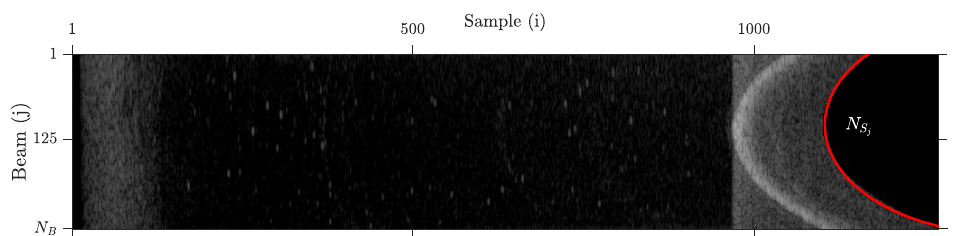
Figure 2. Raw representation as a 1270 × 256-pixel picture of water column amplitude samples from a ping acquired by a Kongsberg EM2040 echosounder. Note that the black area on the right does not contain any sample.